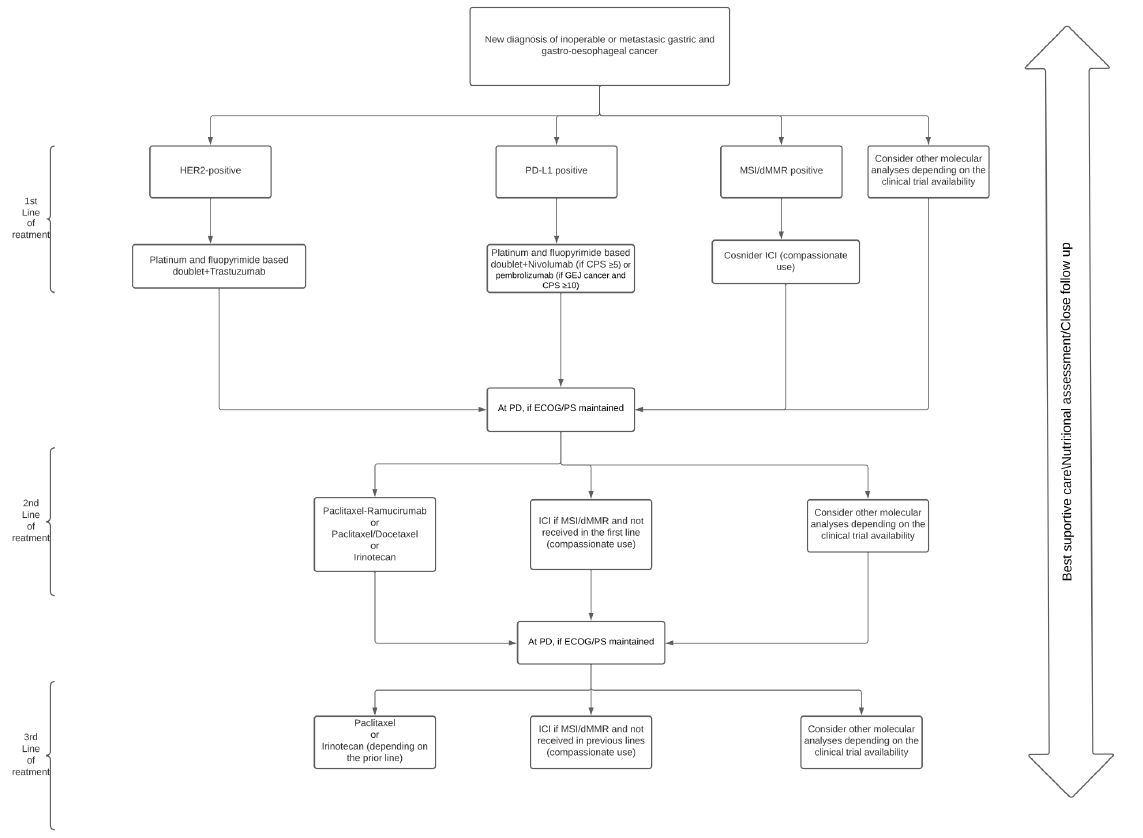
Figure 1. Treatment algorithm of patients with gastric and gastro-oesophageal junction cancer.